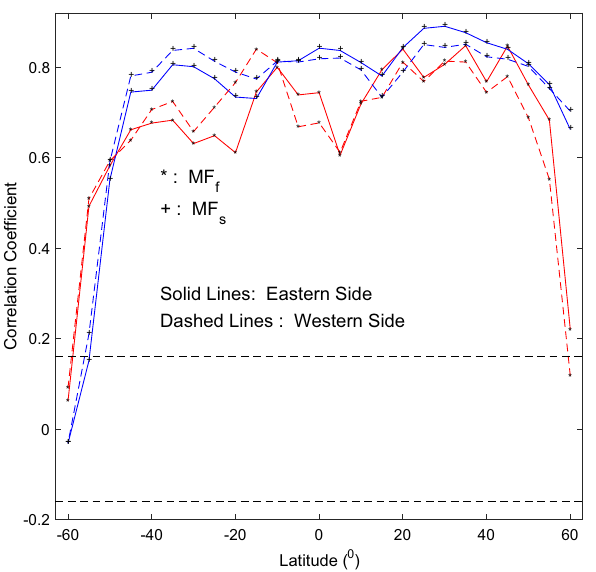
Figure 5. Cross correlation coefficient between time series of CI measured at the east/west solar limbs (solid/ dashed lines), respectively with the magnetic field MF s (asterisks in red lines) and the small-scale magnetic elements Component-II (plus signs in blue lines), at a certain latitude. The two horizontal dashed lines show the 95% confidence